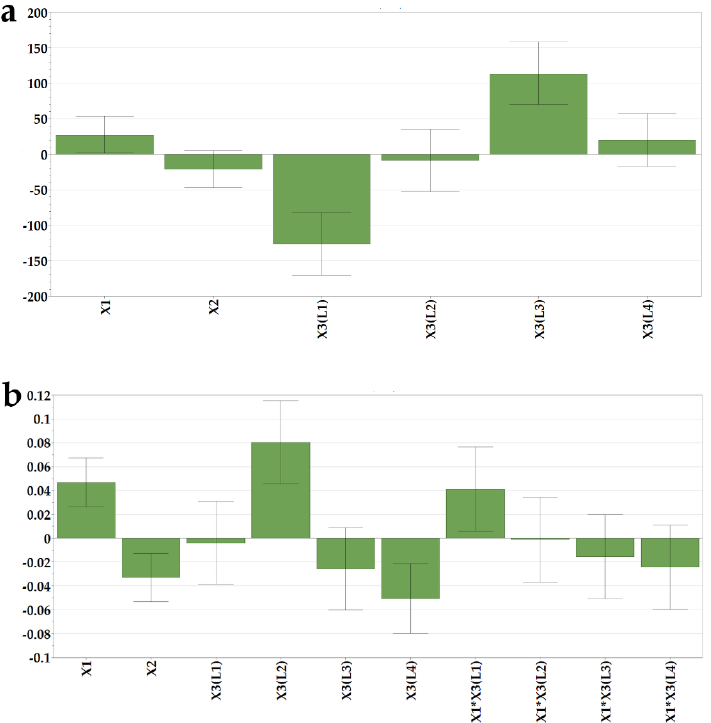
Figure 5. Coefficients of the regression equations are displayed as histograms and representative response surfaces for ( a ) particle size (Y7) and ( b ) polydispersity index (Y8).